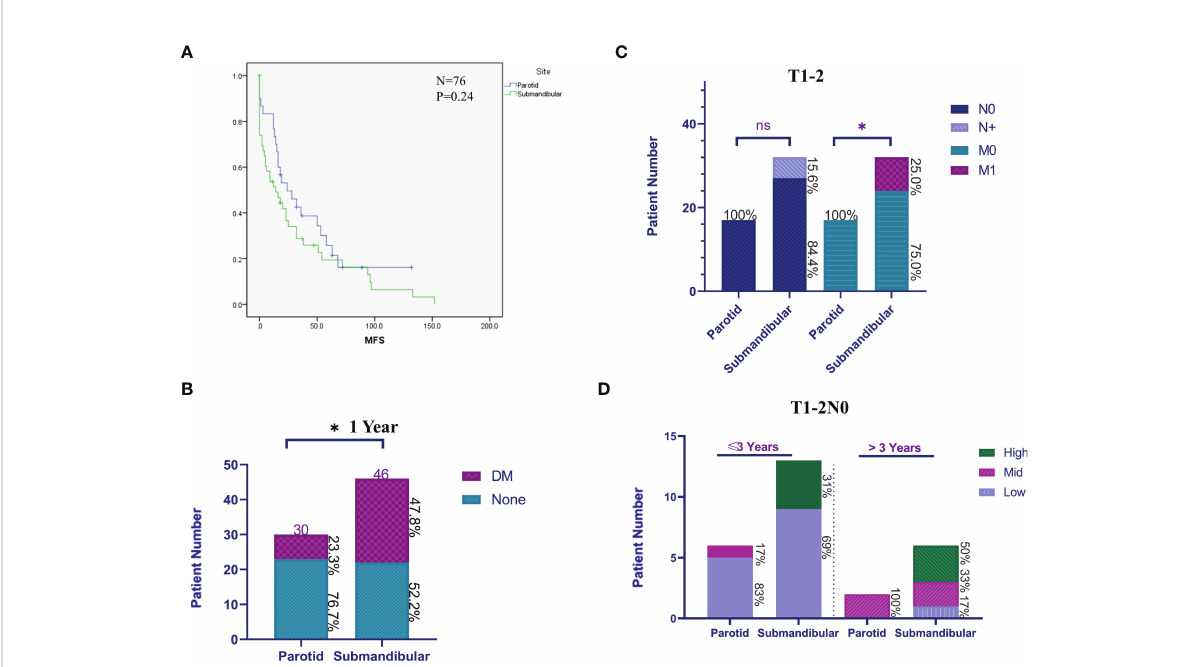
FIGURE 5 Clinical features of patients with submandibular/parotid glands ACC from a single - centre retrospective analysis. (A) The Kaplan-Meier method was used to analyse the differences in distant metastases from ACC of the submandibular and parotid glands. (B) The difference in distant metastases (DM) within 1 year after the primary diagnosis of submandibular and parotid glands ACC. (C) Cervical lymph node and distant metastasis ratio at the fi rst diagnosis of early (T1-2) submandibular and parotid glands ACC. (D) Early (T1-2N0) differences in the rate of progression of distant metastases of submandibular and parotid glands ACC. High: prognostic high-risk status for distant metastasis; Mid: prognostic medium-risk status for distant metastasis; and Low: prognostic low-risk status for distant metastasis (ns: P-value> 0.05; * P-value